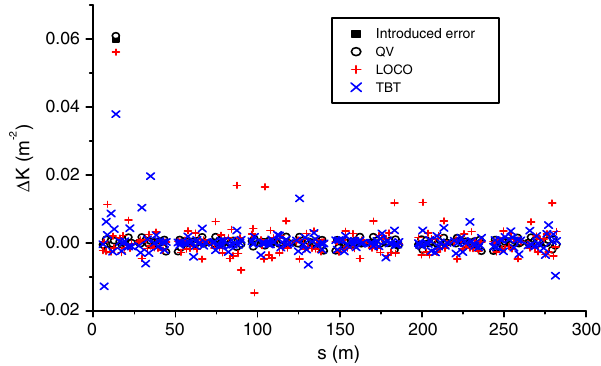
FIG. 10. Single error identification with simulated data. No singular value cut is applied.